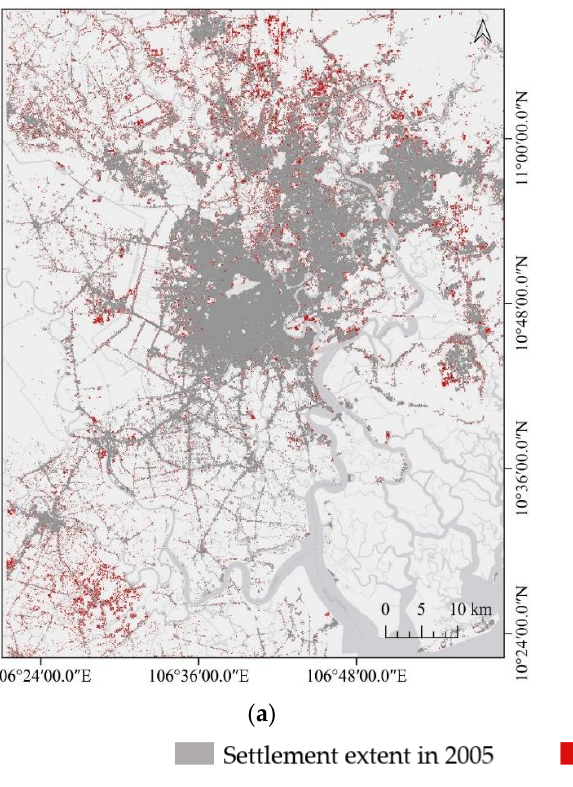
Figure 11. Actual settlement growth map and predicted settlement growth map of HCMC based on the STM-based model from 2006 to 2015. ( a ) Actual settlement growth map of HCMC, generated from the WSF-evolution; ( b ) predicted settlement growth map based on the ten-year strategy and MLP.